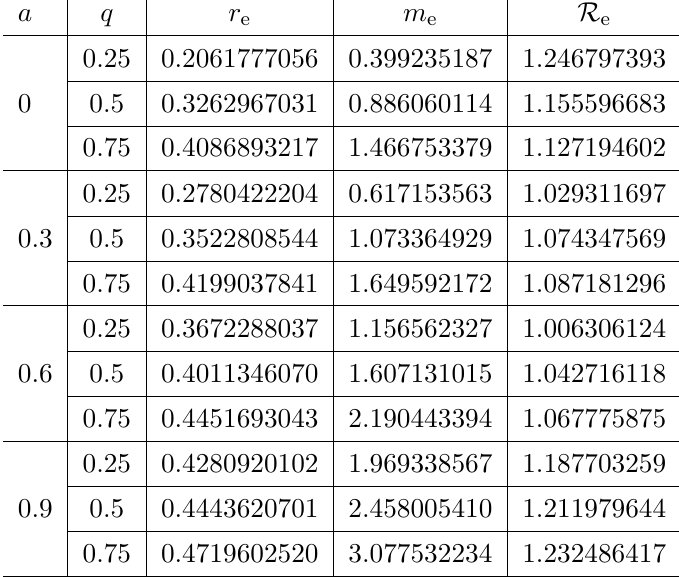
Table 3 . The numerical values of the horizon radius r e , mass parameter m e , and isoperimetric ratio R e with different rotation parameter a and electric charge parameter q in the extremal black hole case ( l = 1